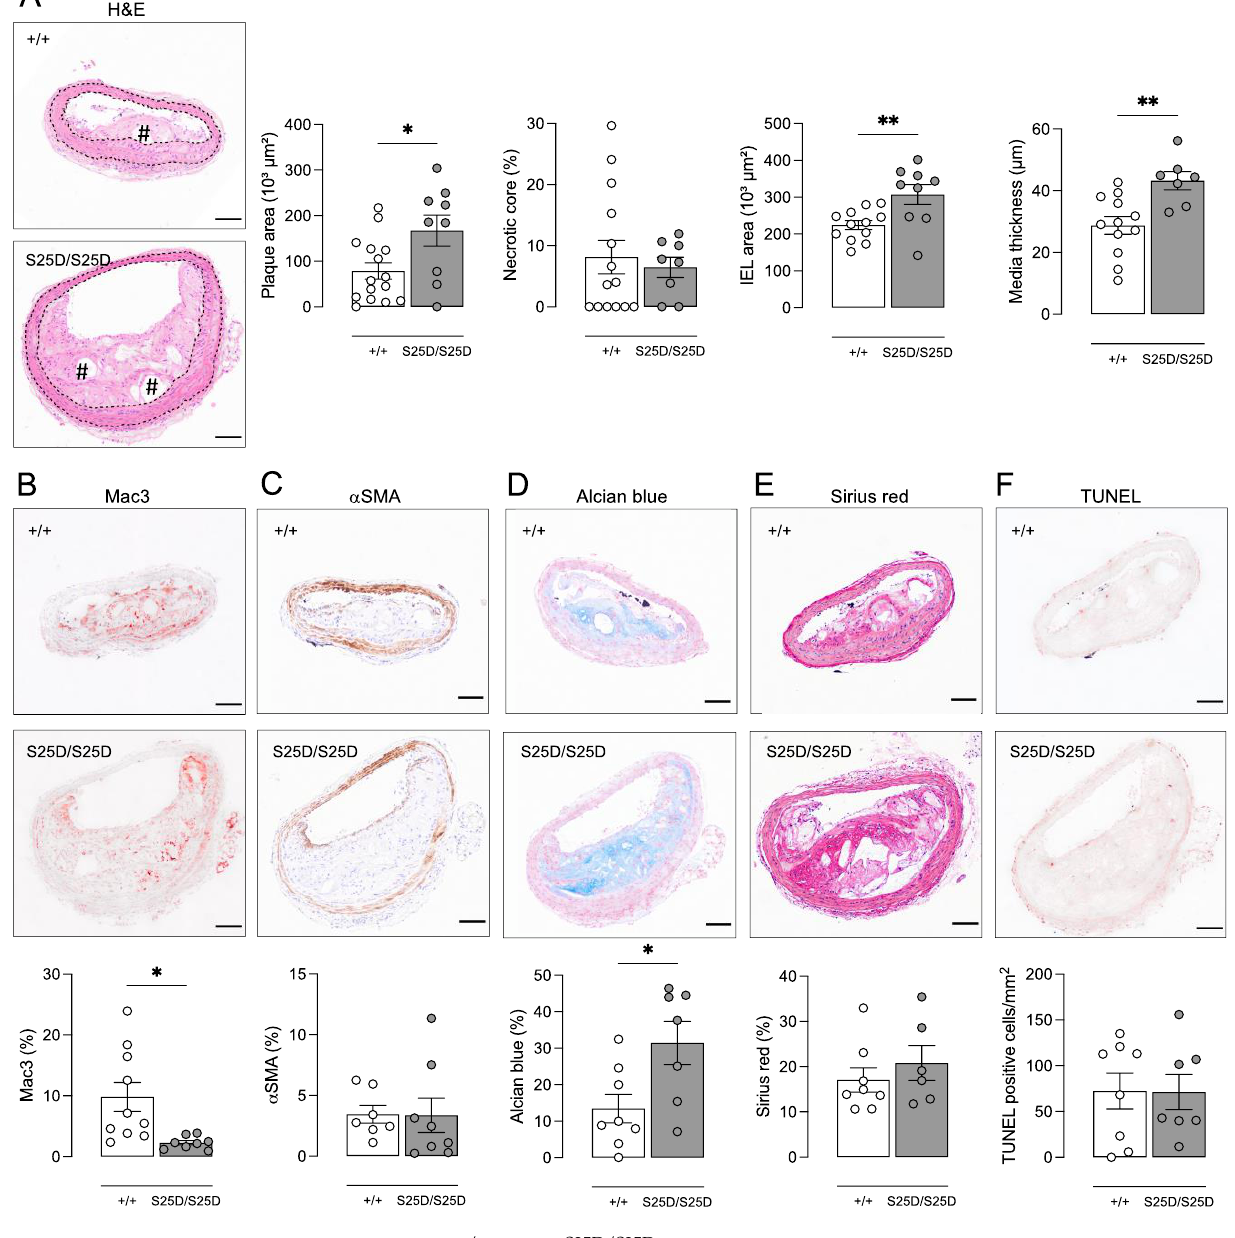
Figure 2. ApoE −/− RIPK1 S25D/S25D mice show positive vascular remodeling and larger plaques with increased deposition of extracellular matrix components. ApoE −/− RIPK1 +/+ and ApoE −/− RIPK1 S25D/S25D mice were fed a WD for 16 weeks. Sections of the brachiocephalic artery were stained with ( A ) hematoxylin/eosin to quantify plaque size, necrotic core (# hash signs) and vessel properties (dotted lines delineate the media), ( B ) anti-Mac3 to determine macrophage content, ( C ) anti- α -smooth muscle actin ( α SMA) to determine vascular smooth muscle cell content, ( D ) Alcian blue to quantify glycosaminoglycans, ( E ) Sirius red to quantify total collagen and ( F ) TUNEL to count apoptotic cells. * p < 0.05, ** p < 0.01 (independent samples t -test, n = 7–15 mice per group). Scale bar = 100 µ m. Representative images are shown.